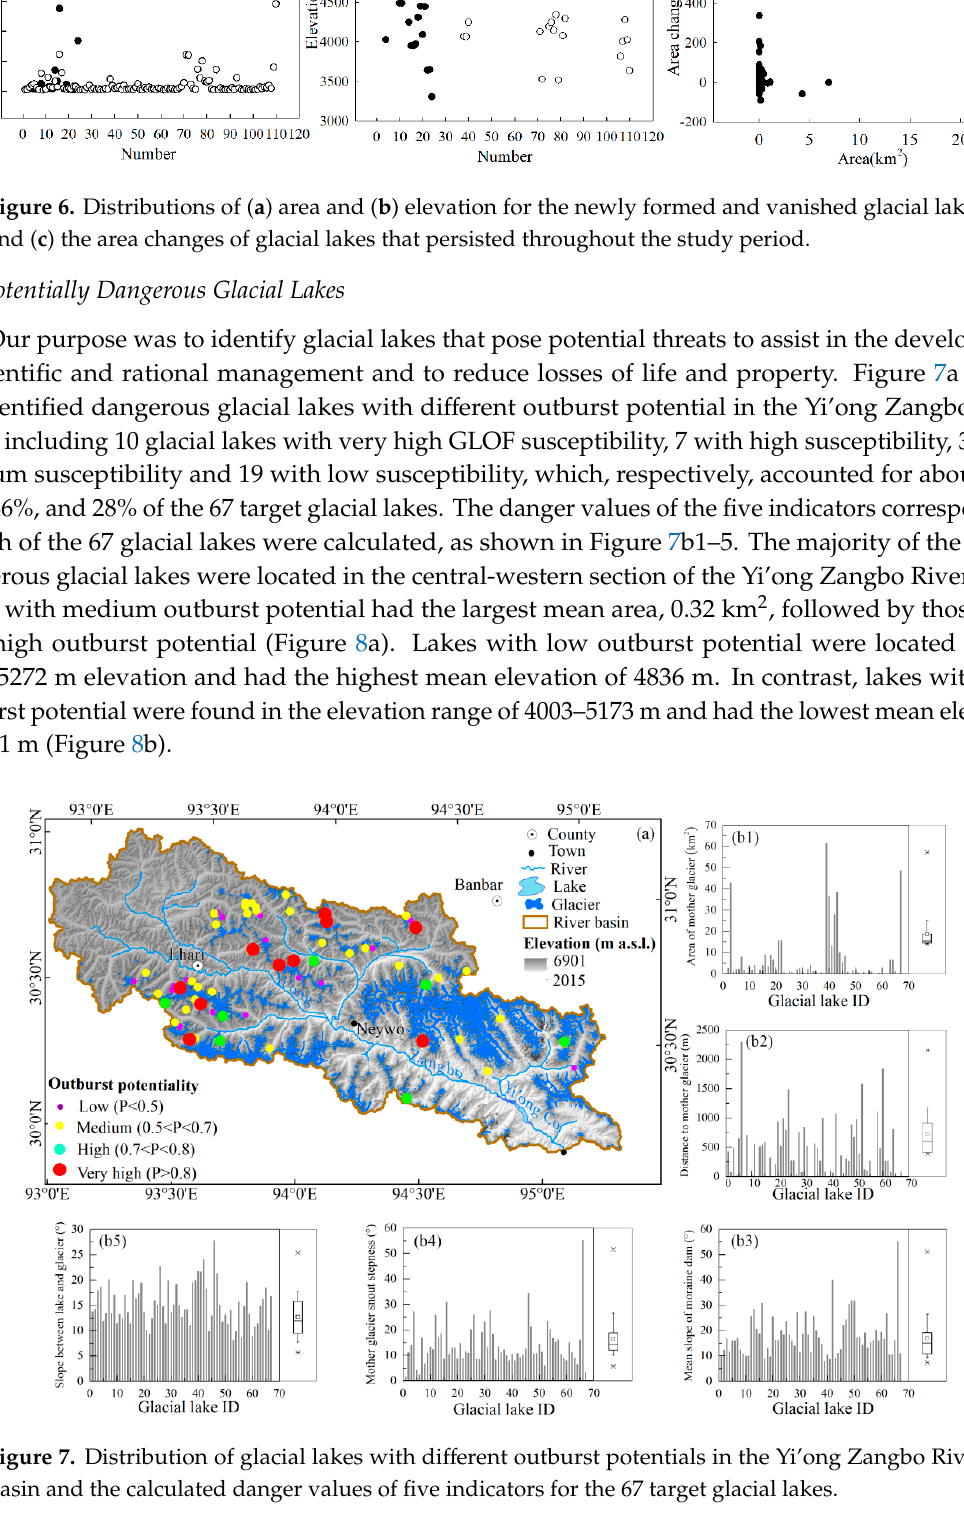
Figure 8. Areas and elevations of glacial lakes with different outburst potentials.